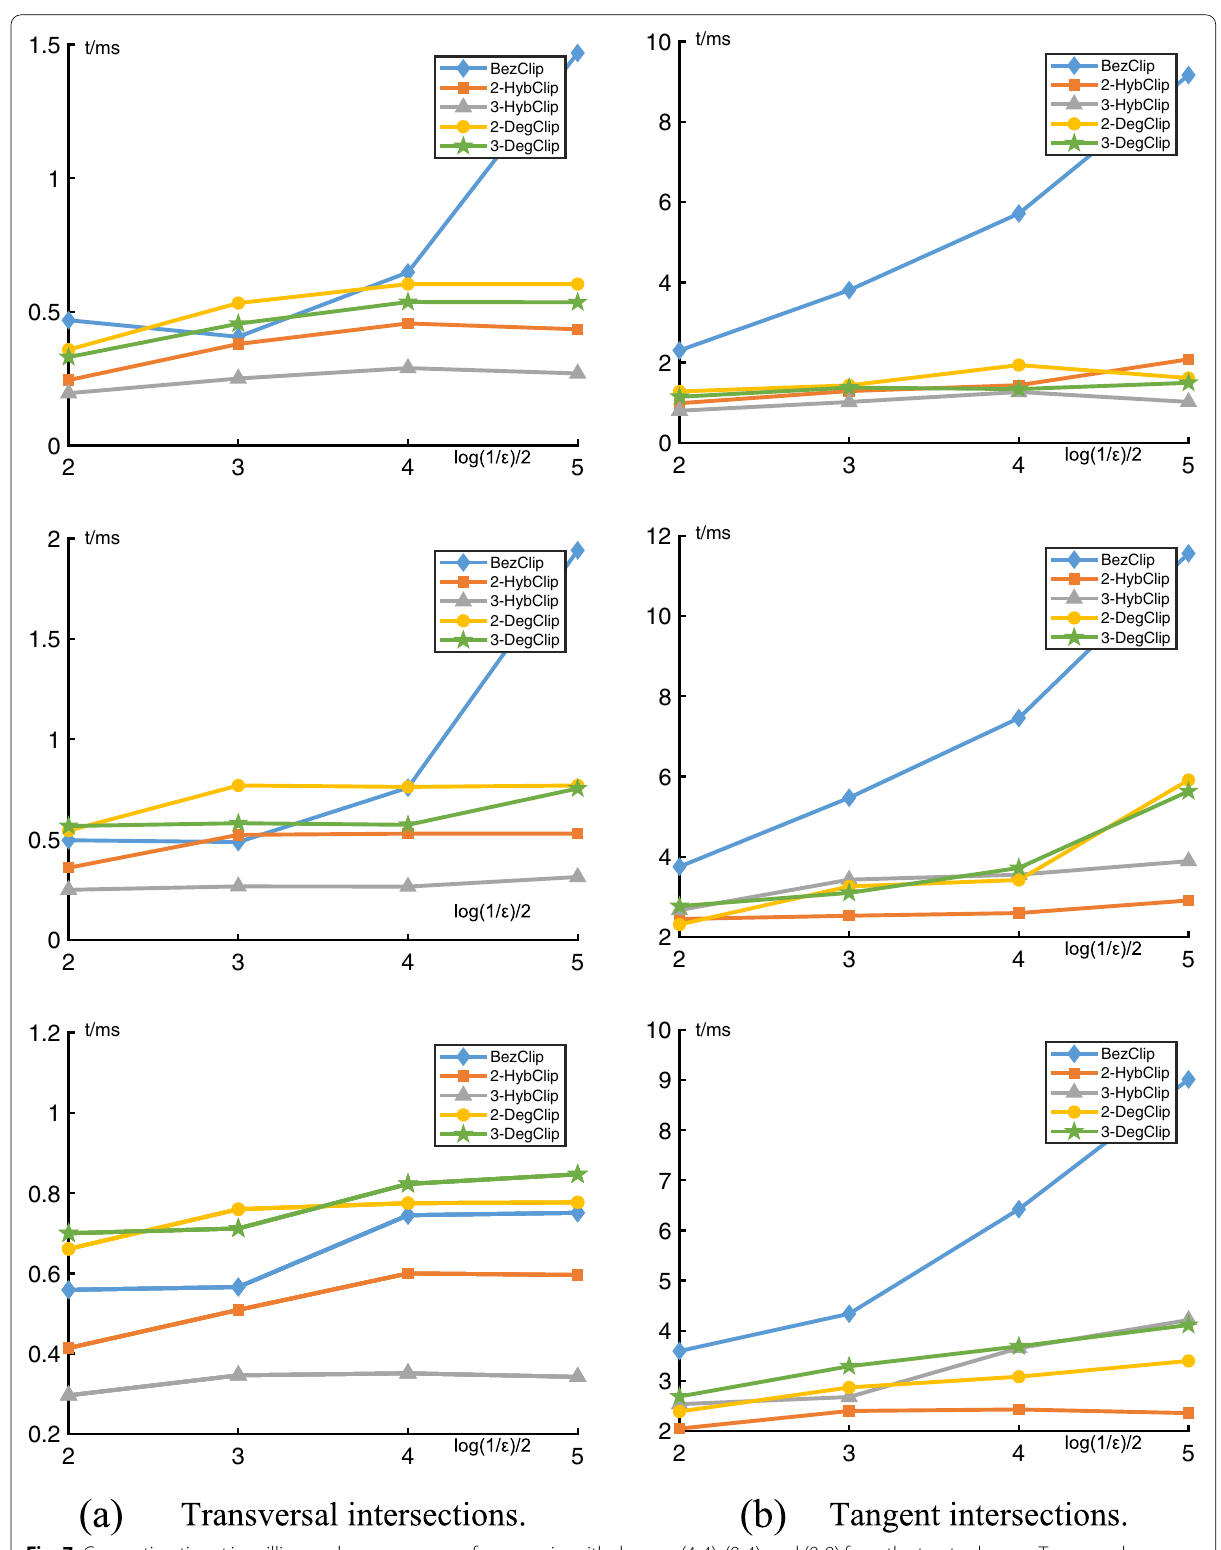
Fig. 7 Computing time t in milliseconds vs accuracy ε of curve pairs with degrees (4, 4), (8, 4), and (8, 8) from the top to down. a Transversal intersections; b Tangent